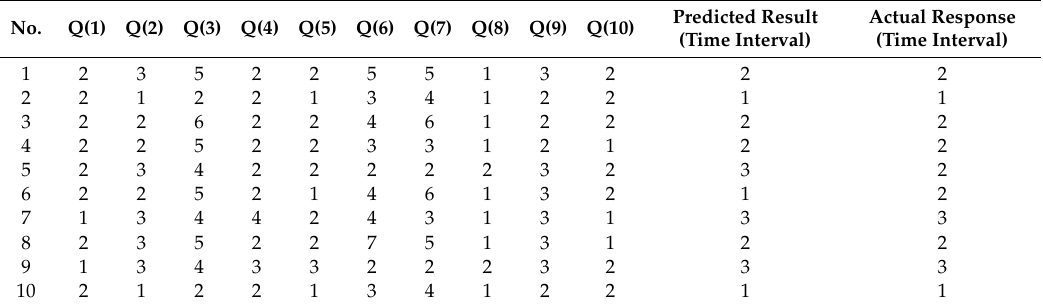
Table 6. The predicted results of RF for multiple input variables and the respondents’ actual responses.